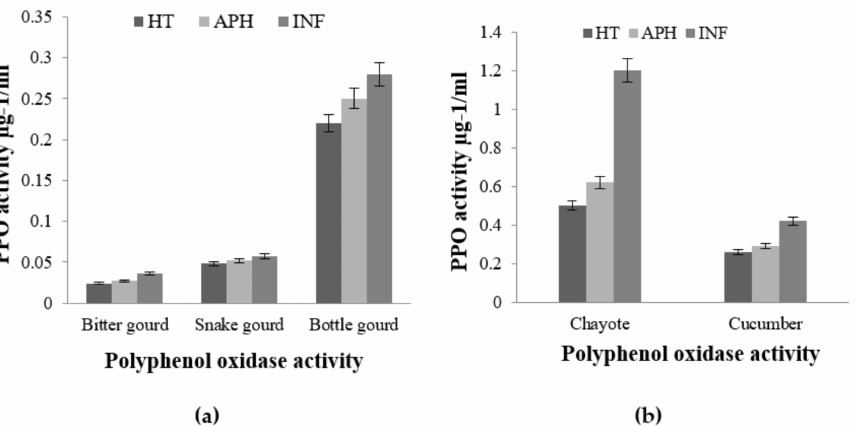
Figure 4. Polyphenol oxidase (PPO) activities of selected healthy (HT), apparently healthy (APH), and infected (INF) cucurbit fruit of Bitter gourd, Snake gourd and Bottle gourd ( a ) and Chayote and Cucumber ( b ) upon melon fly infestation. The vertical bars indicate the standard error. Significance at p ≤